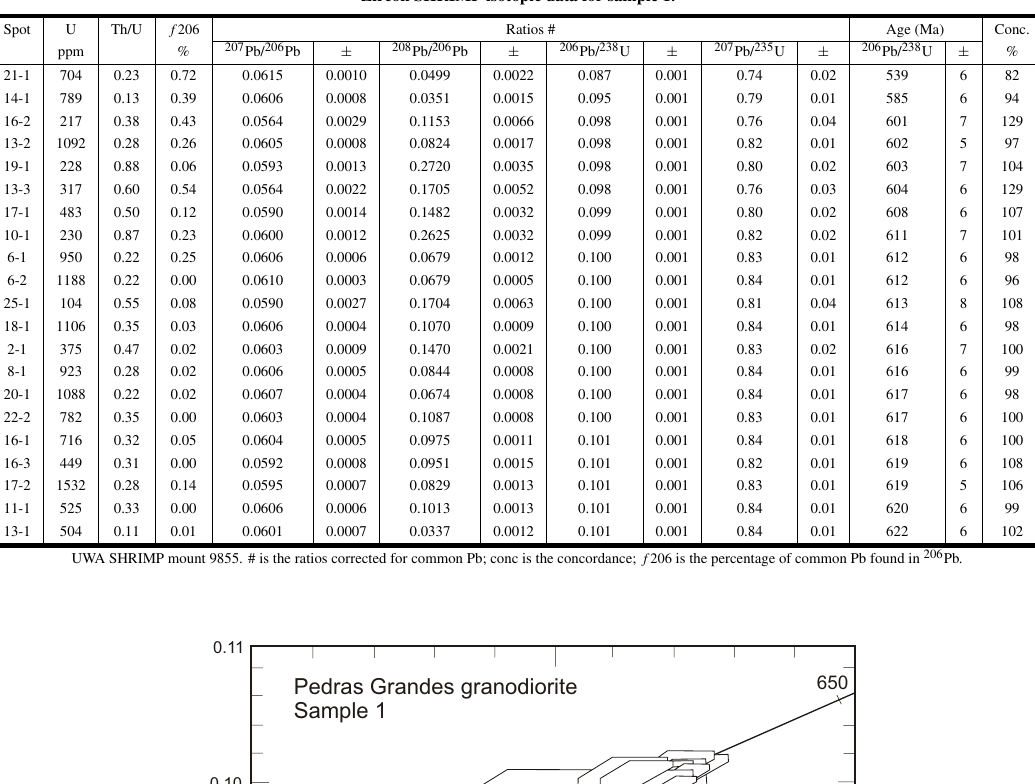
Zircon SHRIMP isotopic data for sample 1.